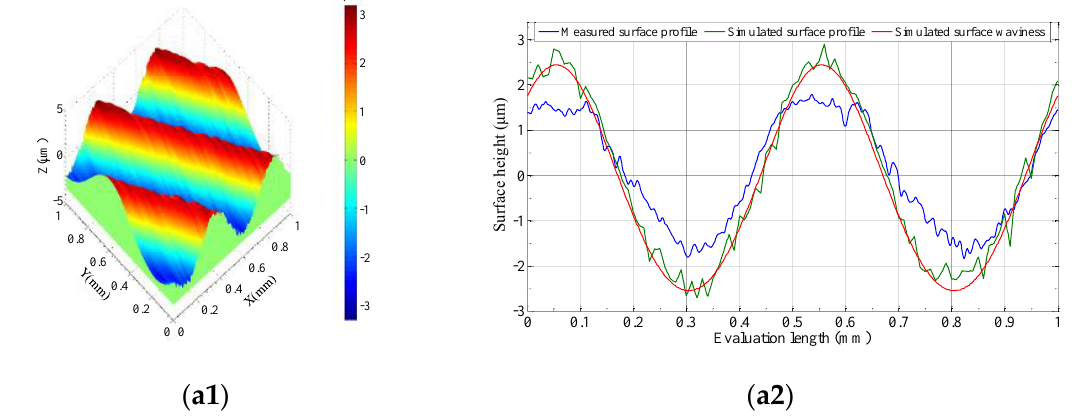
Figure 5. Simulated surface and measured surface under out-of-phase shift (phase = 0): ( a1 ) simulated surface topography; ( a2 ) surface profile height.